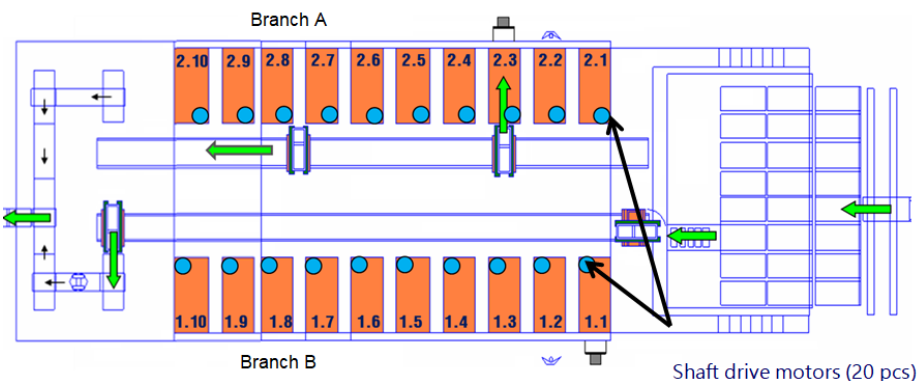
Figure 6. Conformer layout.